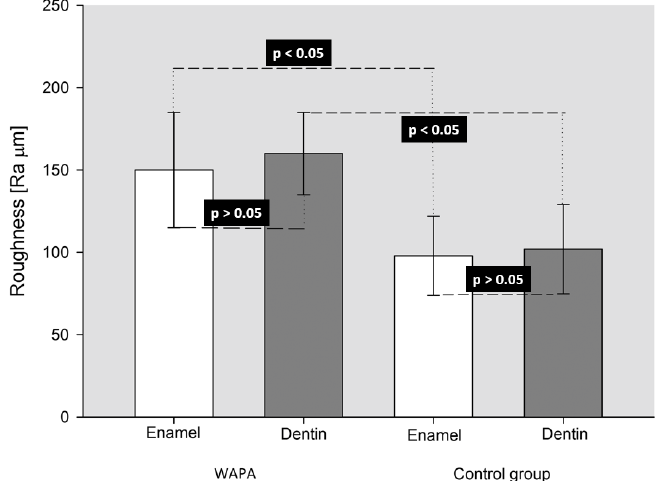
Figure 8. Results of One-way ANOVA ( p = 0.004; power = 0.881 with α = 0.05) and Holm–Sidak pairwise multiple comparison procedures for Ra among both treatments and tissues. WAPA: water– airborne-particle abrasion and acid-etching; Control group: acid-etching only. A statistically signifi- cant difference ( p < 0.05) was present between WAPA and Control group for both enamel and dentin tissues. No statistically significant difference ( p > 0.05) was present between different tissue in the same group of